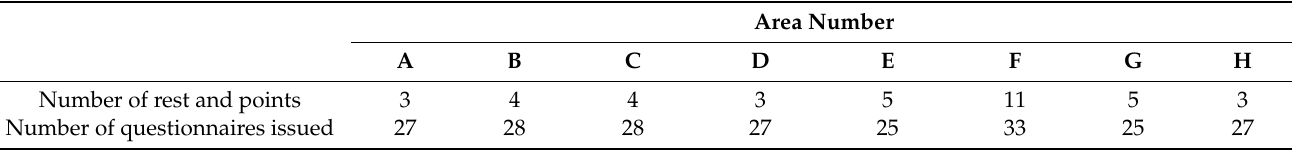
Table 1. Basic survey information table for each